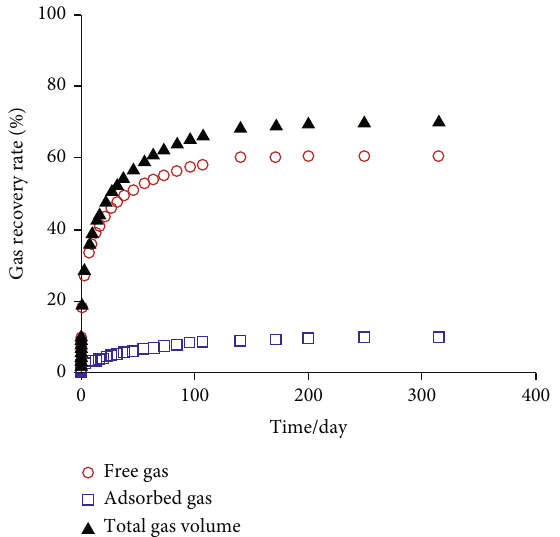
Figure 7: Gas recovery rate versus production time.